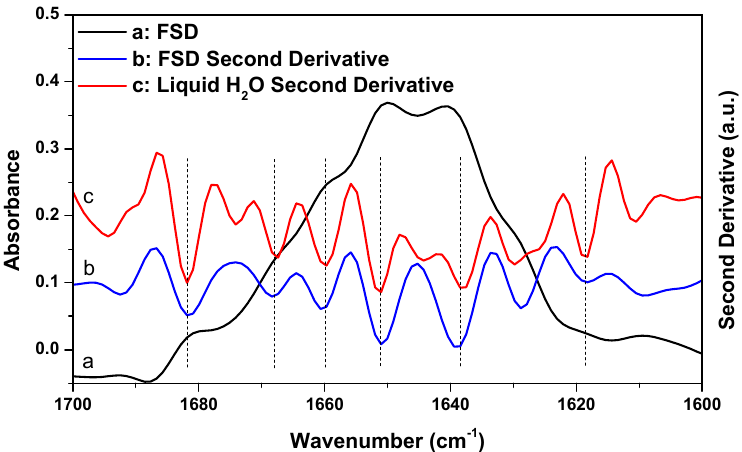
Figure 6. FSD spectrum of HEWL in D and second derivative spectrum of liquid H with its resolved peaks pointing downwards and is in arbitrary unit (a.u.). Spectral resolution: 4 cm − 1